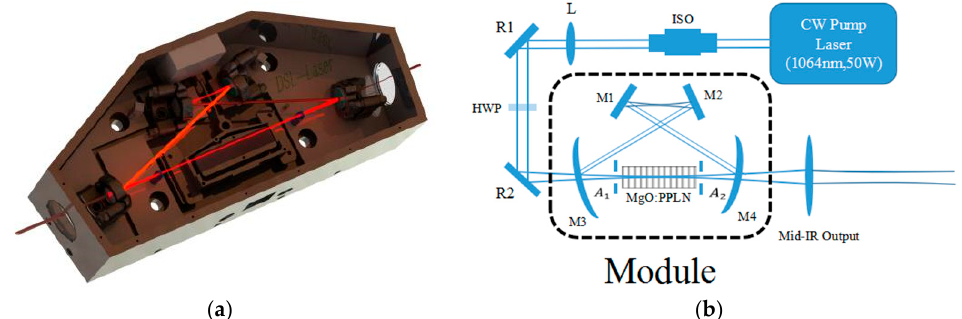
Figure 1. The configuration of the module ( a ) and the optical schematic of the experiment ( b ). HWP: half wavelength plate; ISO: isolator; MgO:PPLN: MgO-doped periodically poled lithium niobate crystal; CW: continuous-wave.